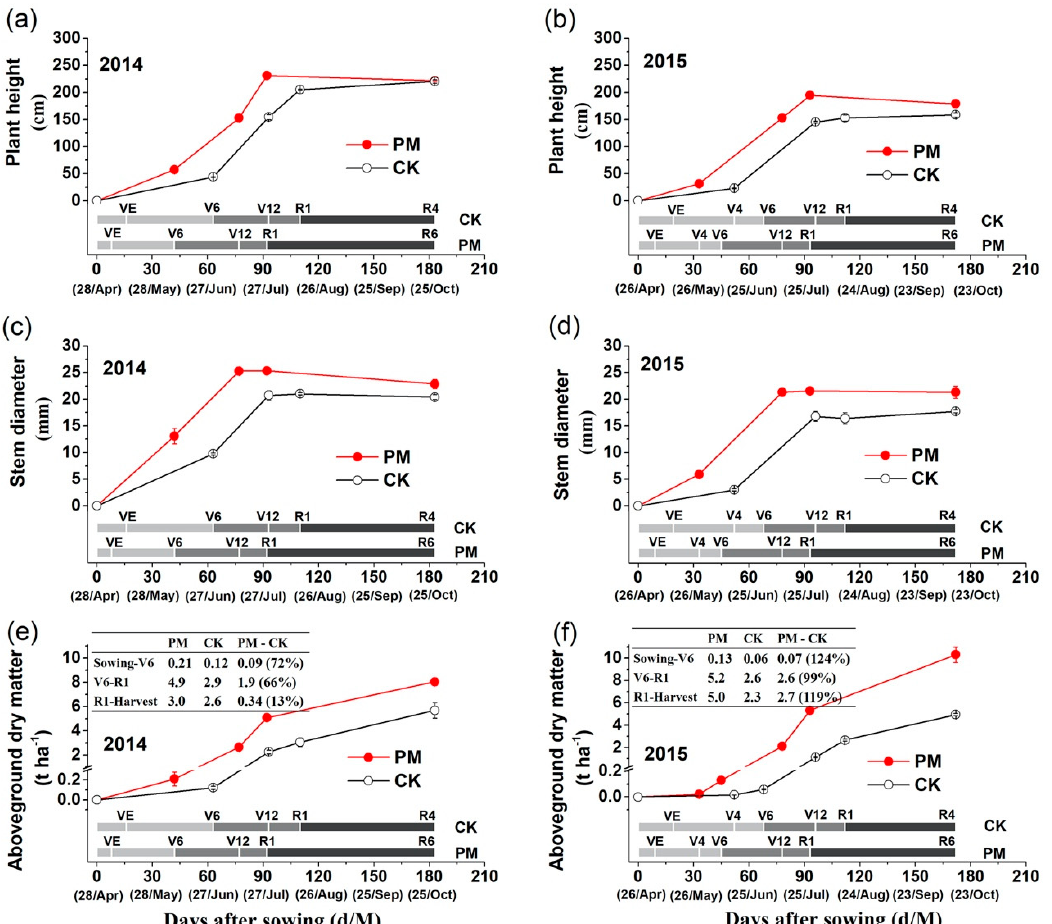
Figure 5. ( a , b ) Plant height, ( c , d ) stem diameter, and ( e , f ) aboveground dry matter in mulched (PM) and check (CK) plots in 2014 (left column) and 2015 (right column). The stacked bar plot in each graph is the duration of stages of corn growth. Vertical bars represent standard errors of the mean. Inset ( e , f ): The aboveground dry matter increases during three periods. Plants in PM had reached R6, while those in CK had only reached stage R4, and had no mature grains due to the rapidly falling air temperature. VE: seedling emergence, V4: four-leaf stage, V6: six-leaf stage, V12: twelve-leaf stage, R1: silking stage, and R6: physiological